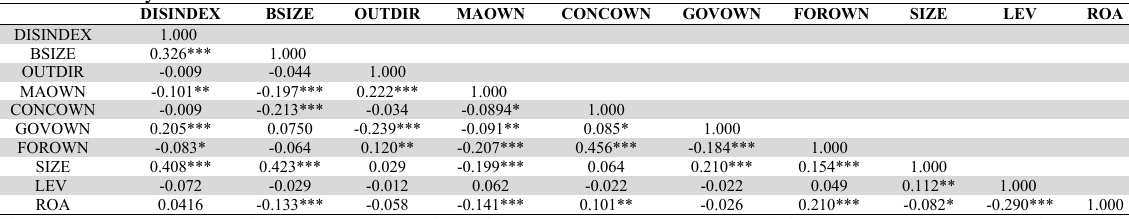
Table 5 Correlation Analysis of Variables DISINDEX BSIZE OUTDIR MAOWN CONCOWN GOVOWN